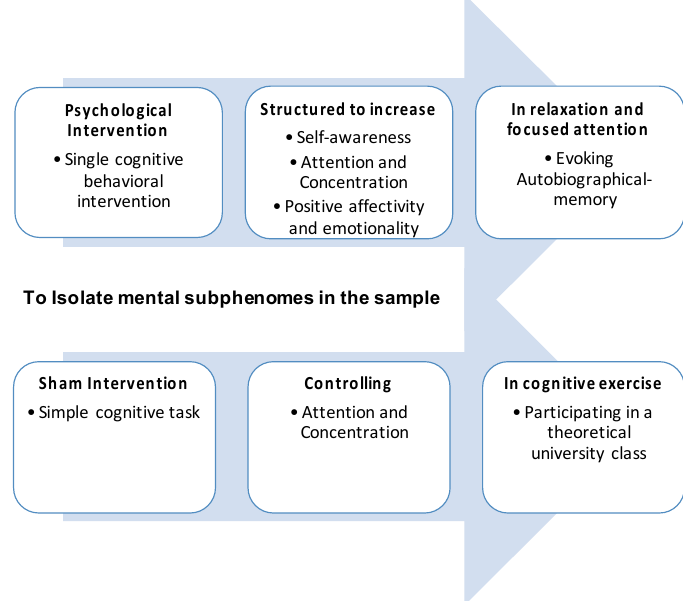
Figure 6. Intervention protocol, comprising the experimental procedure and the sham intervention. A diagram is presented for the graphical representation of the Intervention Protocol used to isolate the mental subphenomes in our neurotypical sample. Two horizontal axes are represented: the superior refers to the experimental procedure, and the inferior to the sham intervention. The experimental procedure, i.e., the psychological intervention, is a single cognitive behavioral intervention structured to increase self-awareness, attention, and concentration, as well as positive affectivity and emotionality. The intervention comprehends a focused evoking of autobiographical memory in a relaxed setting. The sham intervention is a simple cognitive task controlling for attention and concentration in a mental exercise of participating in a theoretical university class.